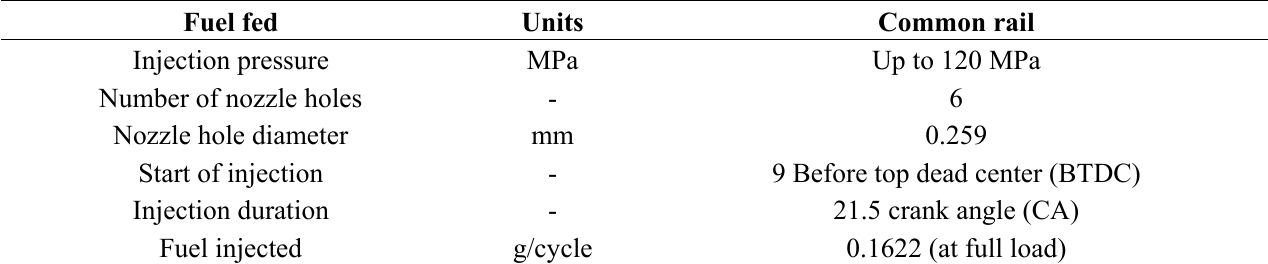
Table 2. Injector fuel system specifications.